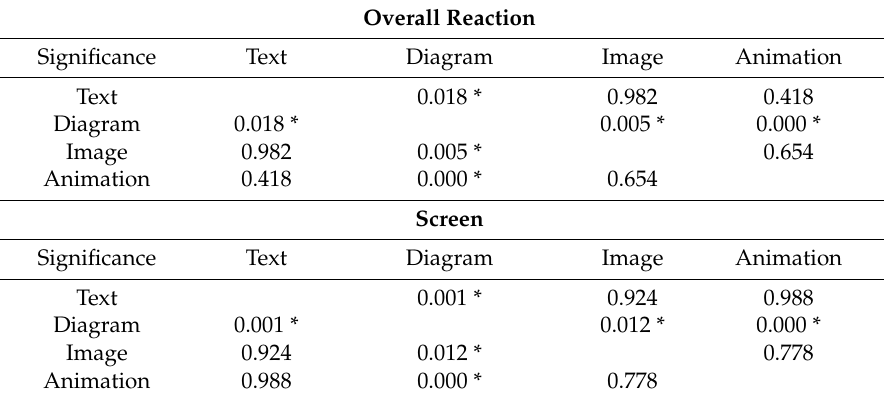
Table 12. Post-hoc test of “overall reaction” and “screen”: significance of the four interfaces.